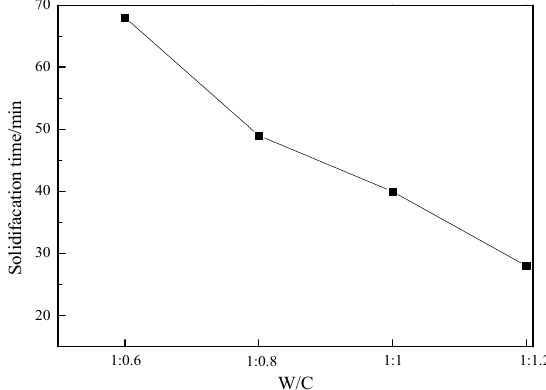
Figure 3. Solidification times of grouting fluids with OPC.